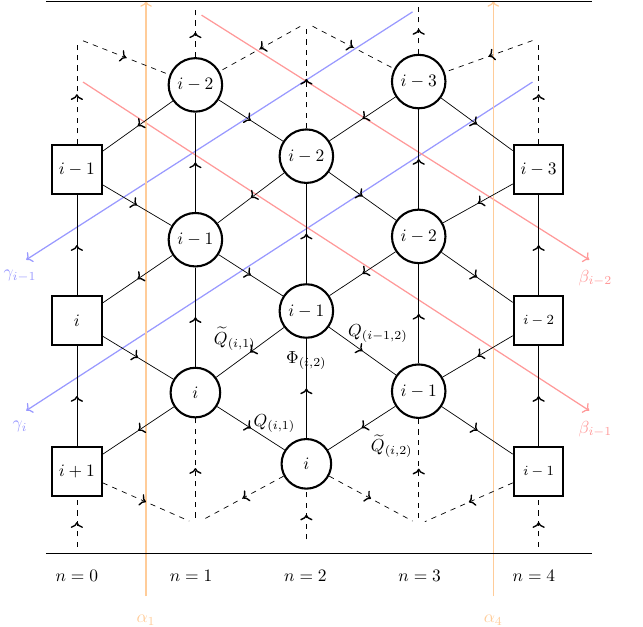
Figure 2. Quiver for a Class S k theory. The gauge nodes are labelled by ( i, n ) , where i = 1 , . . . , k is the Z orbifold index while n = 1 , . . . , ‘ − 3 is the label from the N = 2 mother theory. In this k example we set ‘ − 2 = 4